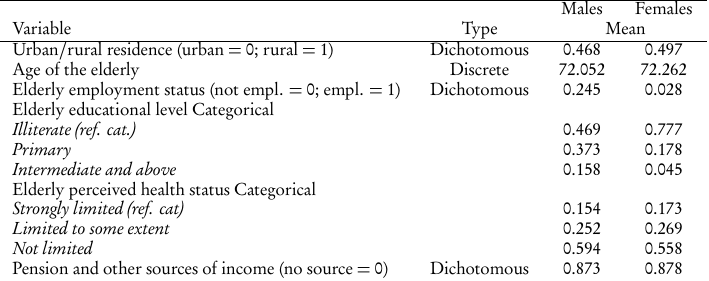
Multinomial logit regression: Independent variables. People 65 years and over, Egypt 2012. Notes: Unweighted